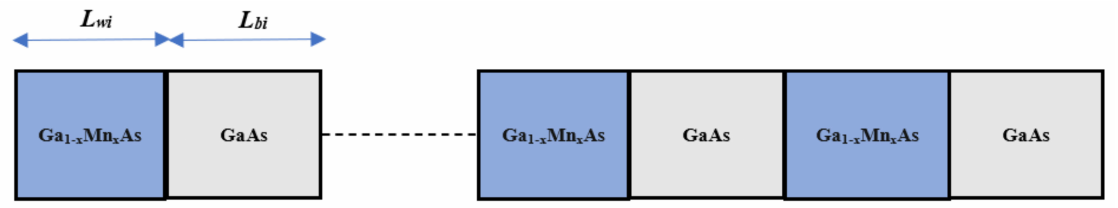
Figure 8. GaAs/Ga 1 − x Mn x As/GaAs system, ( L wi = L bi = 3 nm), N =